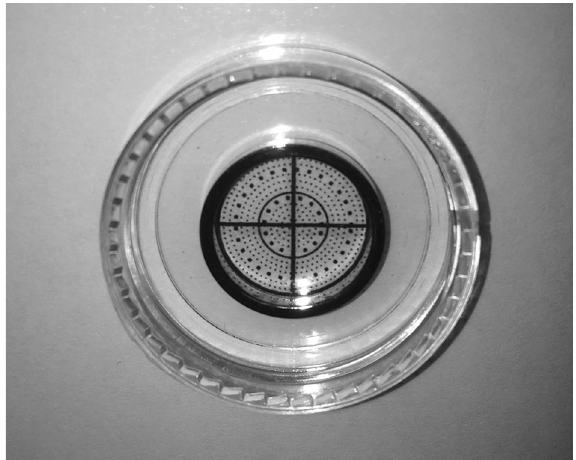
Figure 1. The petri dish filled with balanced salt solution and polar grid of concentric circles with 1-mm steps placed at the bottom. The unfolding process of toric intraocular lenses after ejection from the injector was video- recorded and